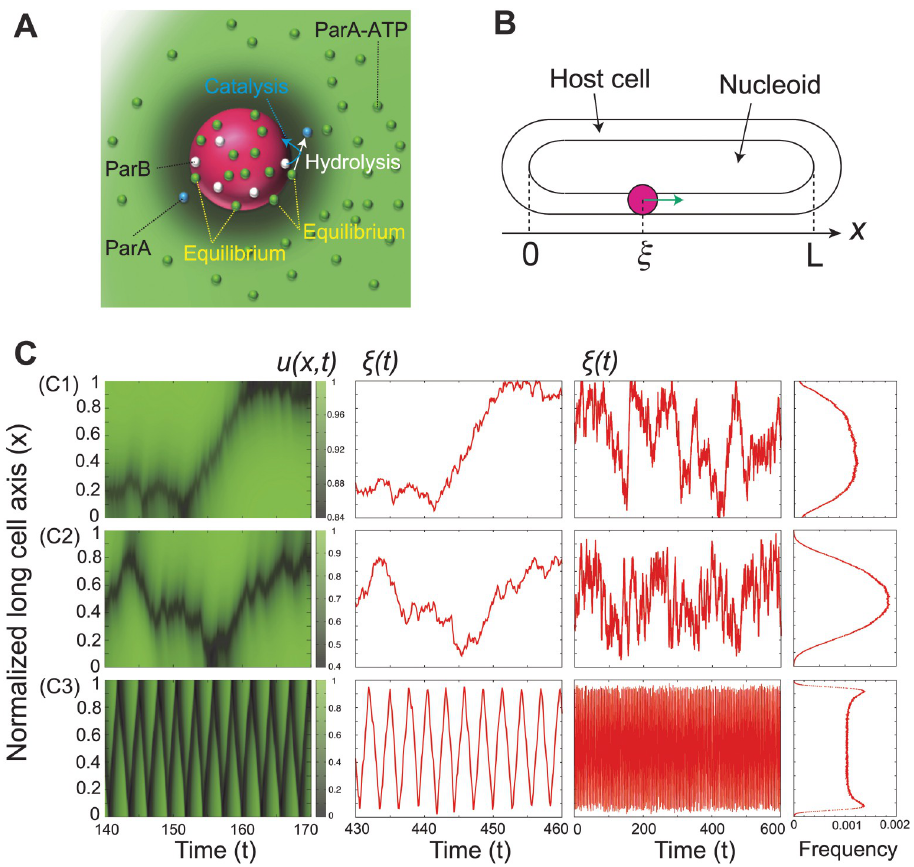
Fig 1. Chemophoresis engine can recapitulate equi-positioning, directed movement, and pole-to-pole oscillation. (A) Schematic representation of the chemophoresis engine. A plasmid moves in a d -dimensional space r 2 R d ( d = 1 or 2). ParA-ATP dimer (green sphere) binds a partition complex (PC, magenta sphere) on the plasmid at position r = ξ i . ParA-ATP dimer molecules interact with ParB molecules (white spheres), which stimulate ParA ATPase activity at a catalytic rate. Because ParA cannot bind PC when it is not combined with ATP, free ParA products (blue sphere) are released from the PC immediately after ATP hydrolysis. Through this reaction on PC i at r = ξ i , each plasmid acts as a sink for ParA-ATP and induces a concentration gradient of this protein. (B) One-dimensional case, on a nucleoid matrix along the long cell axis where a plasmid i (1 � i � M ) is positioned at x = ξ i 2 [0, L ]. (C) The dynamics change among thermal motion, steady center-positioning, and directed movement followed by oscillatory mode as χ increases among χ = 0.5 (C1) , χ = 2.5 (C2) , and χ = 10 (C3) (two inner figures). (C1) The plasmid slightly tends to be localized at the cell center but it is still dominated by thermal fluctuations for M = 1 and χ ≔ kN / V = 0.5. (C2) It is stably localized at the cell center for M = 1 and χ = 2.5, and (C3) it shows directed movement, reflection at the end walls, and pole-to-pole oscillation for M = 1 and χ = 10. The corresponding ParA-ATP pattern dynamics also change among stochastic, steady center-positioning, and oscillatory waves (left). The oscillatory behavior of plasmids does not disrupt time-averaged center-positioning, but steady center-positioning of plasmids are sustained (Compare (C2) right and (C3) , right). K = 0.1, ε = 5, and L = 5. The distributions (right) were generated using 10 7 samples over 10 5 time step. d